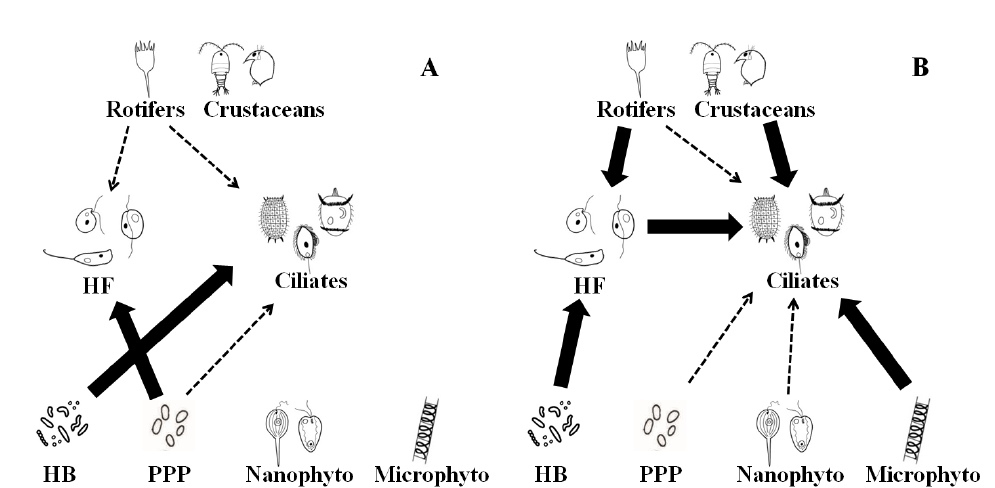
Figure 2. Schematic representation of the best models selected by the Akaike criterion to explain the variation in abundance (A) and biovolume (B) of protists. The continuous arrows represent the negative relations, whereas the dashed arrows represent the positive relations. HF= heterotrophic flagellates; HB= heterotrophic bacterias; PPP= picophytoplankton; Nanophyto= nanophytoplankton and Microphyto= microphytoplankton.